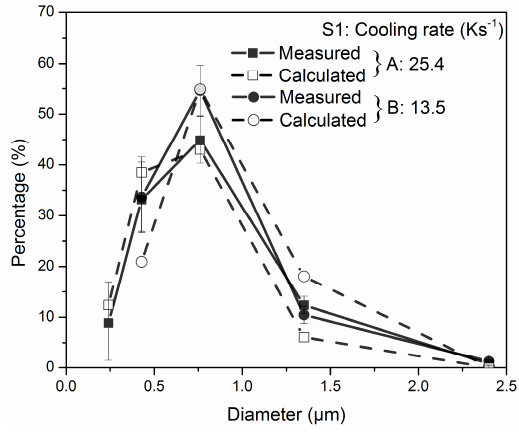
Figure 11. Evolutions of the size distribution of MnS [64].